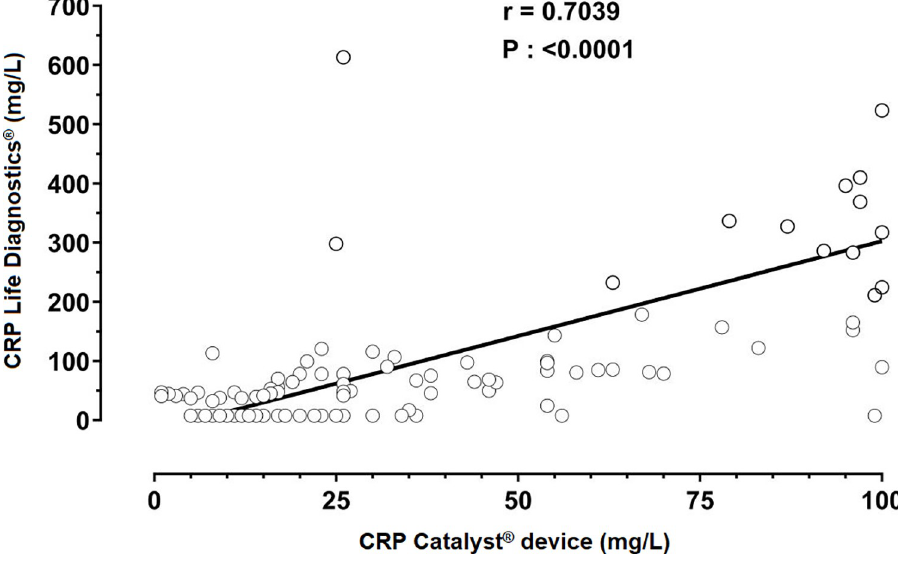
Fig 5. Linear regression plot of the determination of C-reactive protein concentrations in two methods (Life Diagnostics 1 versus Catalyst 1 device) in stage IV CKD dogs submitted to intermittent hemodialysis and clinical